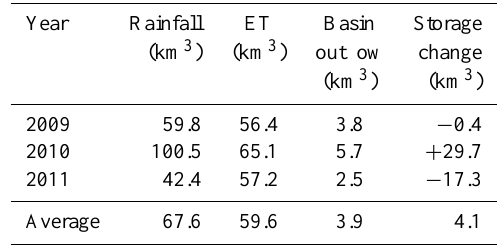
Table 6. Annual water balance of the Awash Basin for the selected hydrological years. The basin area is 116449km 2